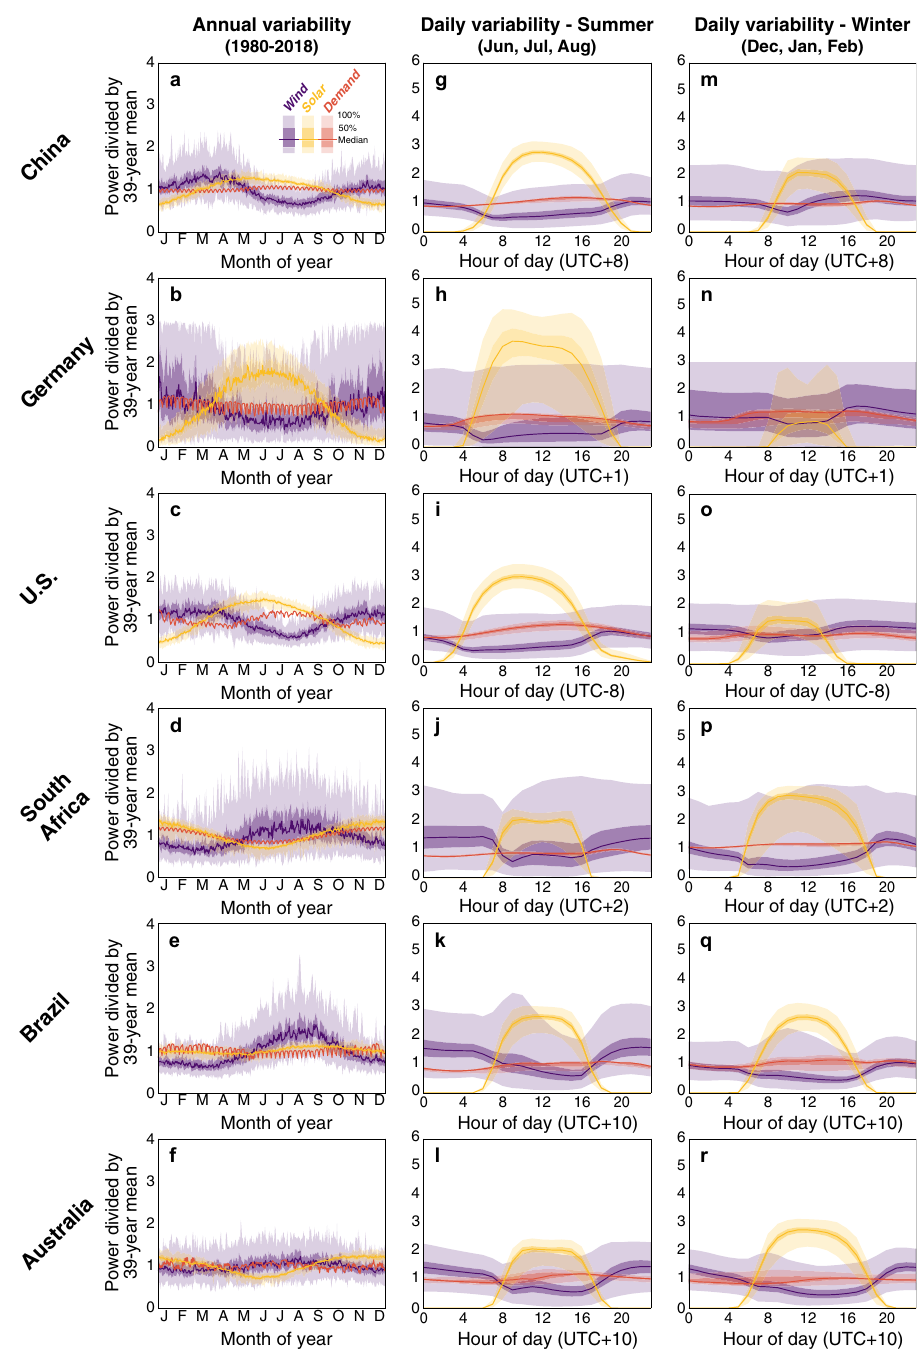
Fig. 1 Temporal variability of solar and wind resources and electricity demand. Climatological variability of the area-weighted median power from solar (orange) and wind (blue) resources for the selected country from six continents during the 39-year period 1980 – 2018. The countries (from the top row to the bottom row) are China ( a , g , m ), Germany ( b , h , n ), contiguous U.S. ( c , i , o ), South Africa ( d , j , p ), Brazil ( e , k , q ), and Australia ( f , l , r ). The left column ( a – f ) depicts the daily and seasonal variability, the middle column ( g – l ) depicts hourly summer (June, July, and August) variability, and the right column ( m – r ) depicts hourly winter (December, January, and February) variability. The lines represent the median, the dark shading represents the inner 50% of observations (25th to 75th percentile) and the light shading represents the outer 50% of observations (0th to 100th percentile) of the daily averaged value for that same day in each of the 39 years of record. Red curves in each panel represent electricity demand for a single, most recent, available year for each country. The time of day shown is the local time of each country and its relation to Coordinated Universal Time (UTC) is shown. Note that the middle of local time zones has been selected for the countries with multiple time zones. The solar, wind, and demand data are each normalized by dividing by their respective 39-year mean